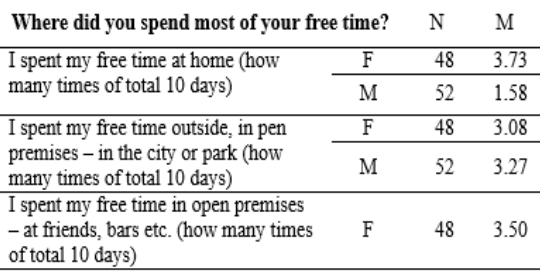
Table 2. How do the surveyed high school males and female spend their free (with whom)